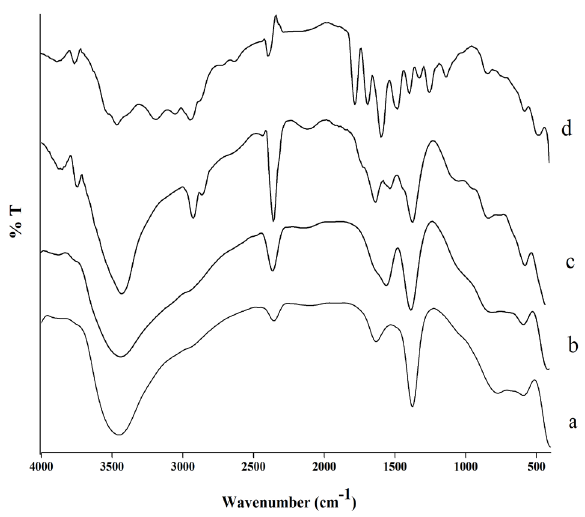
(a); Ni-Al-Benzoate (b); Ni-Al- 3